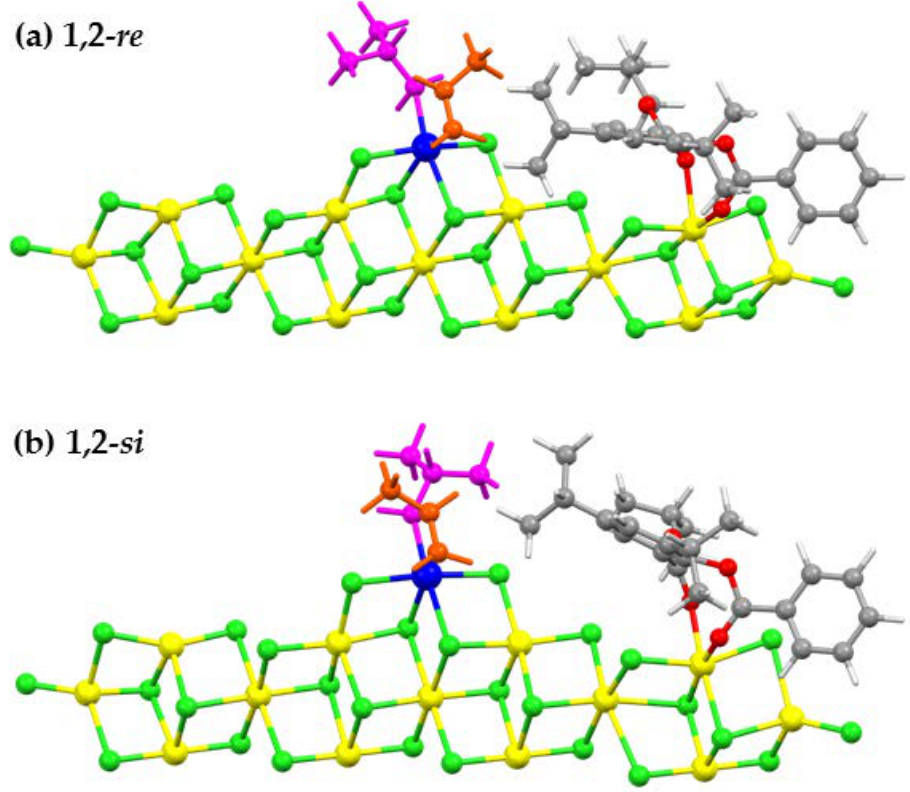
Figure 6. Structures of the transition sates of ( a ) 1,2- re and ( b ) 1,2- si insertions of ZN-catalyzed PP polymerization with salicylate (SID-4) donor.